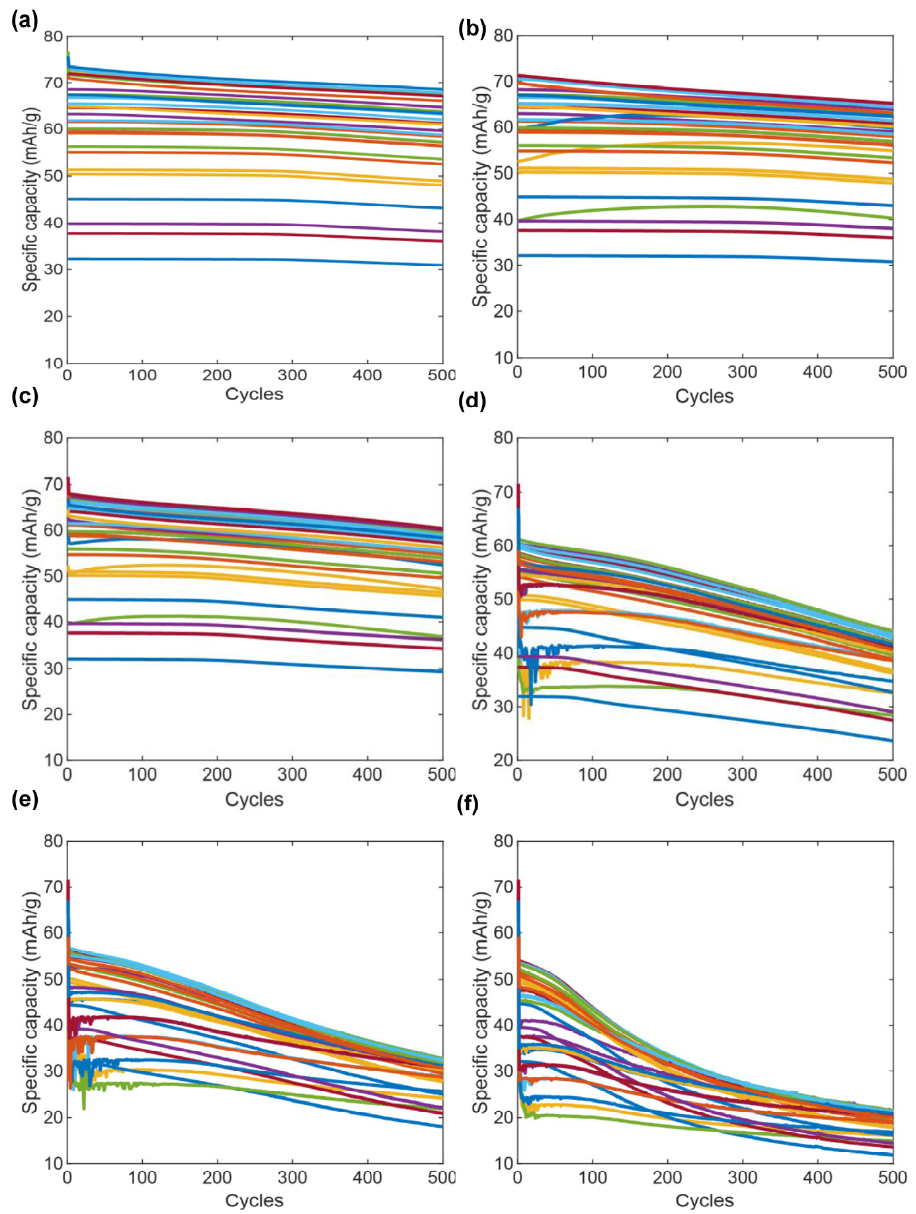
Figure 5. Capacity fade curves for the DOE cells under different charge rates: ( a ) 0.1 C charge–0.1 C discharge; ( b ) 0.12 C charge–0.23 C discharge; ( c ) 0.23 C charge–0.23 C discharge; ( d ) 0.7 C charge–0.23 C discharge; ( e )1.2 C charge–0.23 C discharge; ( f ) 3 C charge–0.23 C discharge.